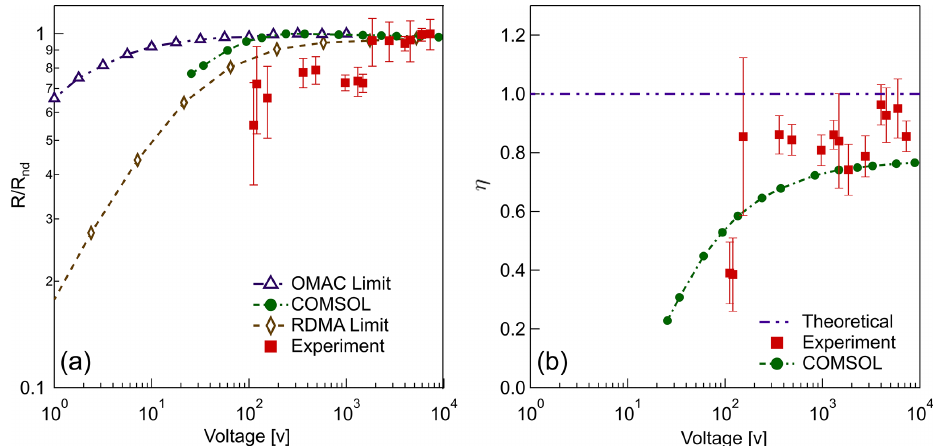
Figure 9. Comparison between experimental, simulated, and theoretical transfer functions. (a) The effect of operating voltage on classifier resolution calculated as the actual resolution based on the full width at half-maximum (FWHM) (Eq. 24) over R nd , the resolution at the non- diffusive regime ( > 5000V). (b) Particle transmission efficiency as a function of operating voltage. Transmission efficiency, η , is calculated as the ratio of the actual over the ideal area below the transfer function peak. The error bars represent 1 standard deviation of uncertainty from multiple experiments at one